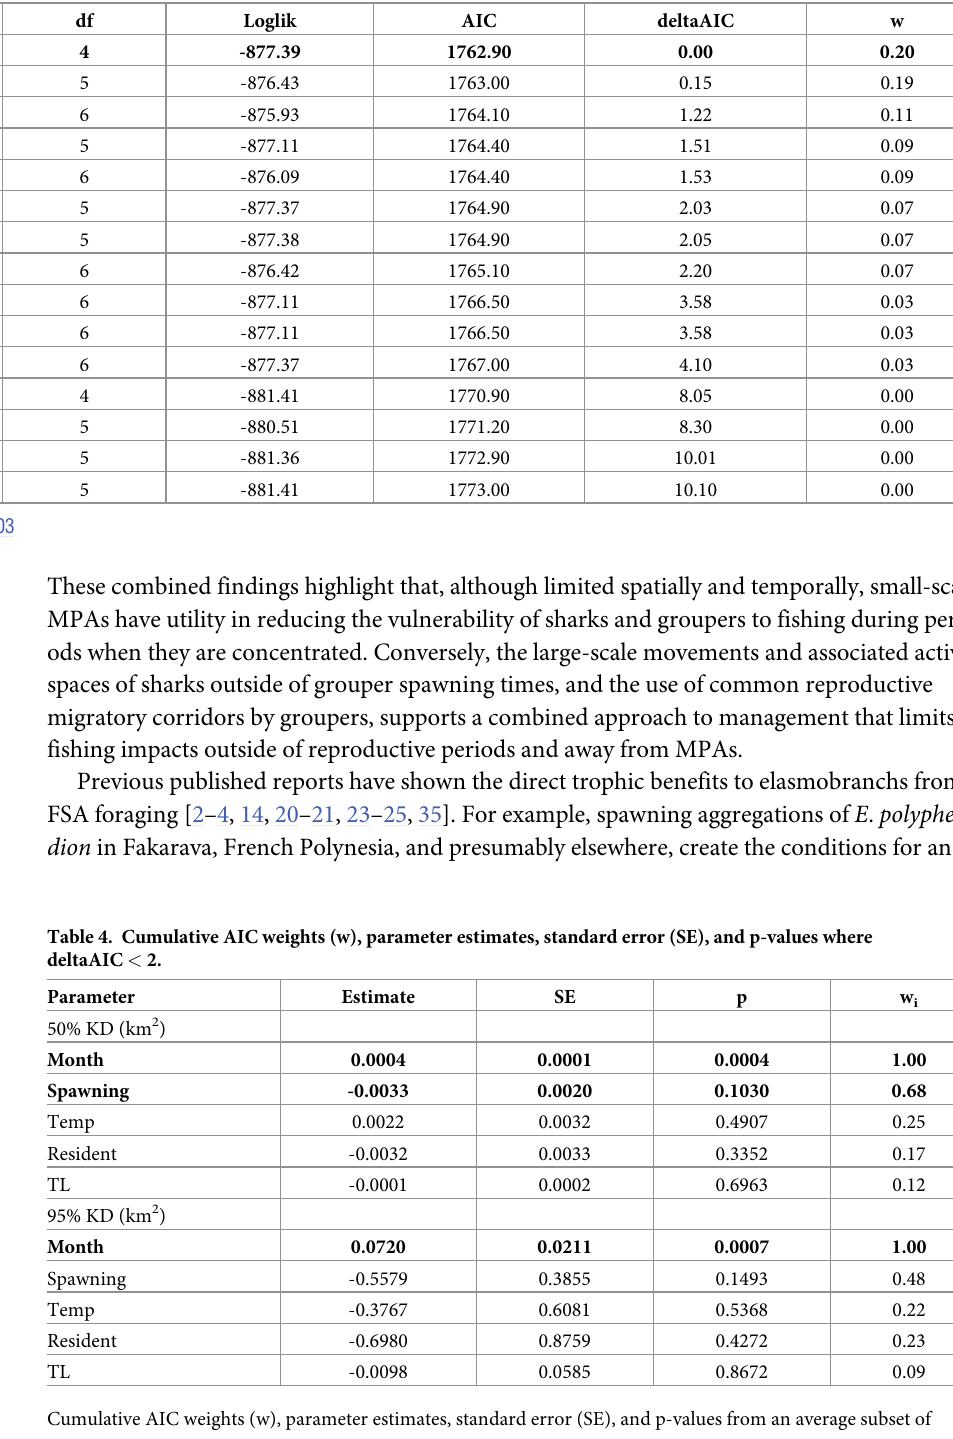
Table 3. The 15 top-ranked GLMMs for the 95% Kernel Density (KD) activity spaces.